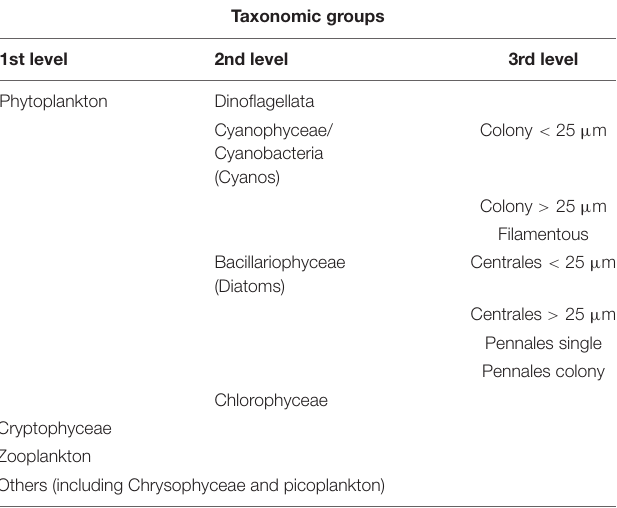
TABLE 1 | Division of the biological community in taxonomic groups.